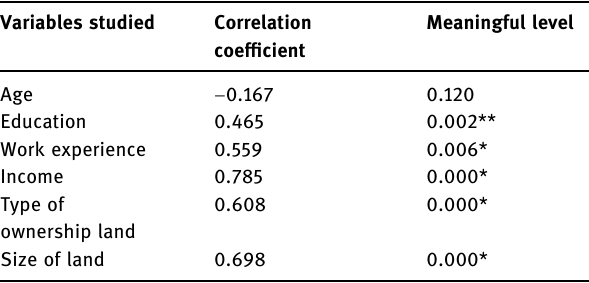
Table 4: Relationship between the development of